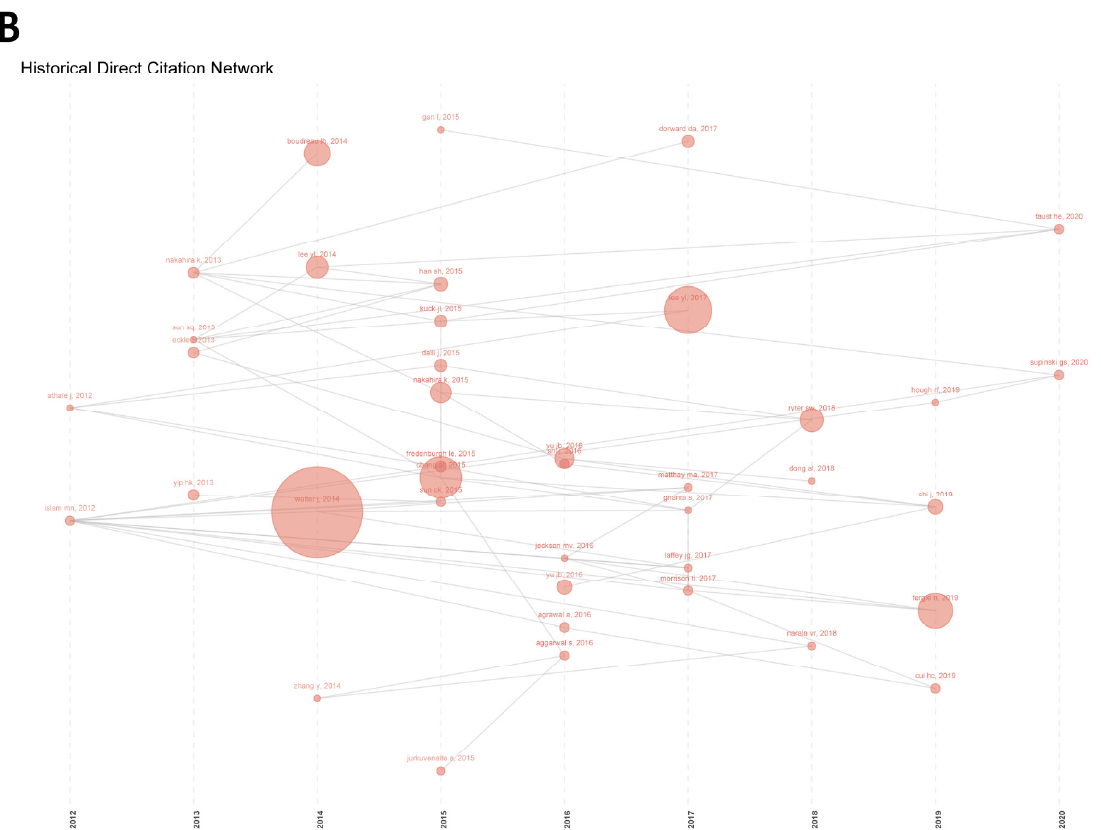
Figure 5. ( A ) The yearly number of local citations of papers with high local citation scores (LCS). Note: The size and colors of the circle represent the LCS of papers in that year. The larger the size and the more yellow the color of the circle, the higher the LCS is . ( B ) One paper cited by the other papers with the top 40 LCS. Note: Each node in the figure signifies a key article, and the directional arrow specifies the citation association between the two articles. The size of each node is proportional to the frequency of this article by the other 39